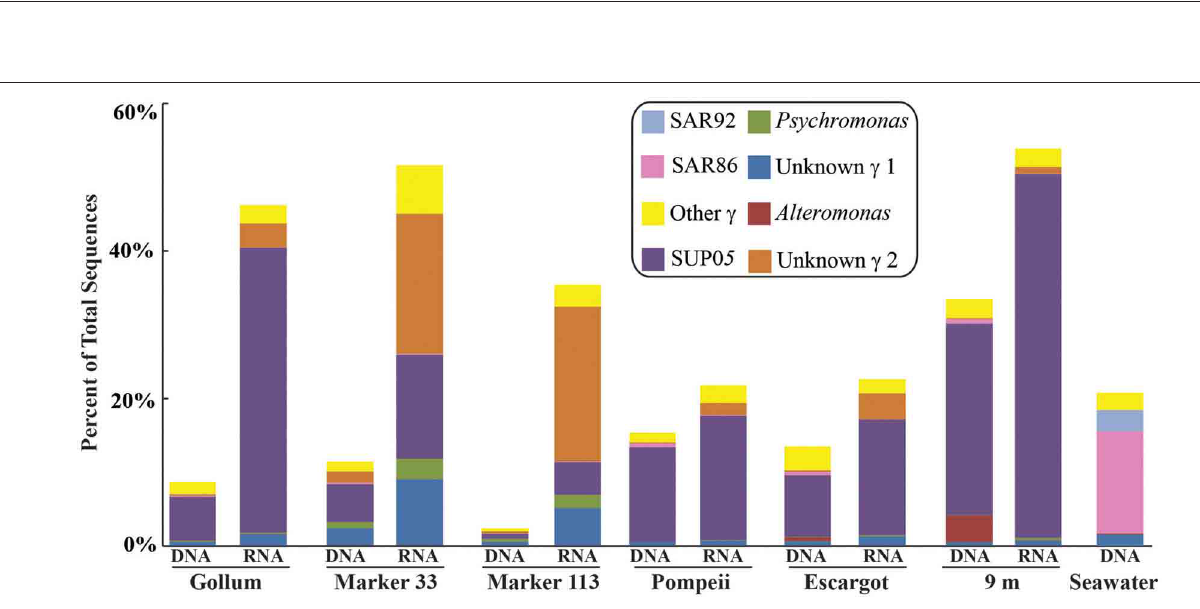
Frontiers in Microbiology | Extreme Microbiology July 2013 | Volume 4 | Article 185 |